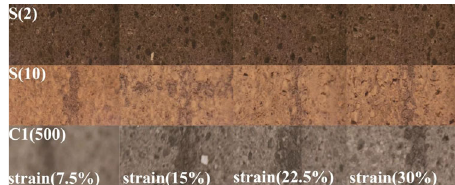
Figure 5: Microphotography (MP) results for group C1 (0 ° crack).